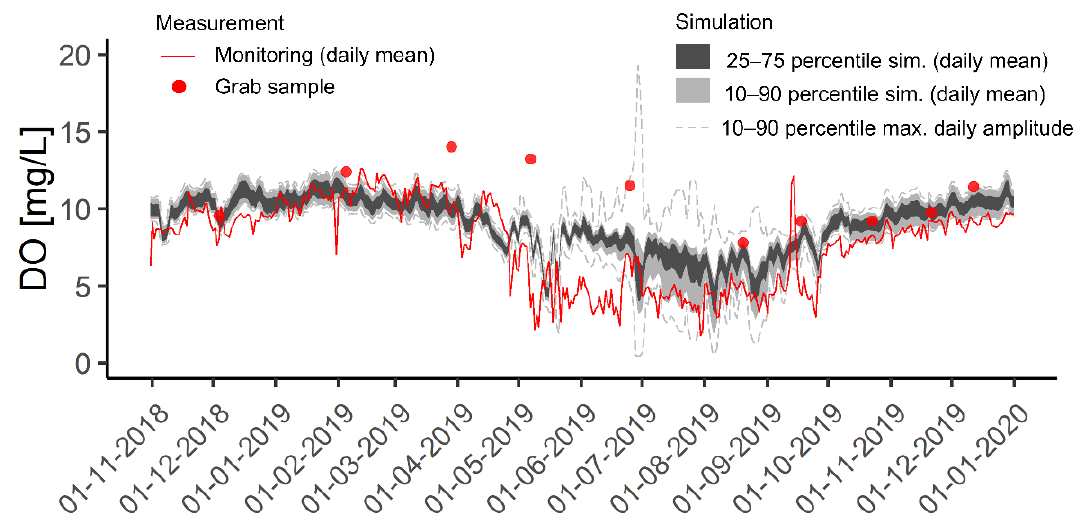
Figure 7. MC simulation results at Parallelvej for the DO concentration (gray and black shading/lines) compared to the online sensor (red line; located under a bridge in the shade) and grab sample measurements (red circles, measured in the afternoon) j. The results are shown for the verification period only. The gray and black shadings show the 10–90 percentiles of estimated daily DO concentrations. The dashed grey lines show the 10–90 percentiles of maximum daily amplitude resulting from photosynthesis/respiration. Input parameter distributions can be found in Table S5.